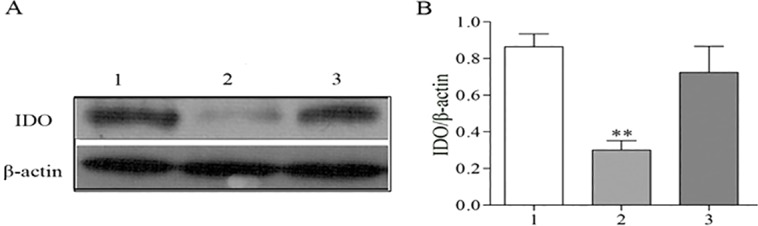
IKKα regulates the expression of IDO in vitro. NRK52E cells were cultured with lymphotoxin-LIGHT to active the IKKα pathway (lane 1), transfected with GV118-GFP-shRNA-IKKα lentiviral vectors (lane 2) or transfected with control vectors (lane 3). (A) The protein levels of IDO were measured by western blotting. (B) The levels of IDO were normalized to β-actin. Data are presented as mean±s.d., **P<0.01 versus the control vector.